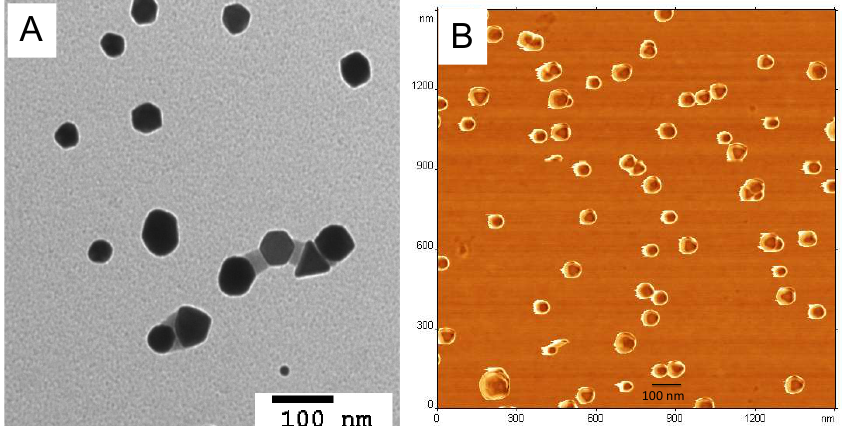
Figure 3. ( A ) TEM and ( B ) AFM images of purified gold nanoparticles.